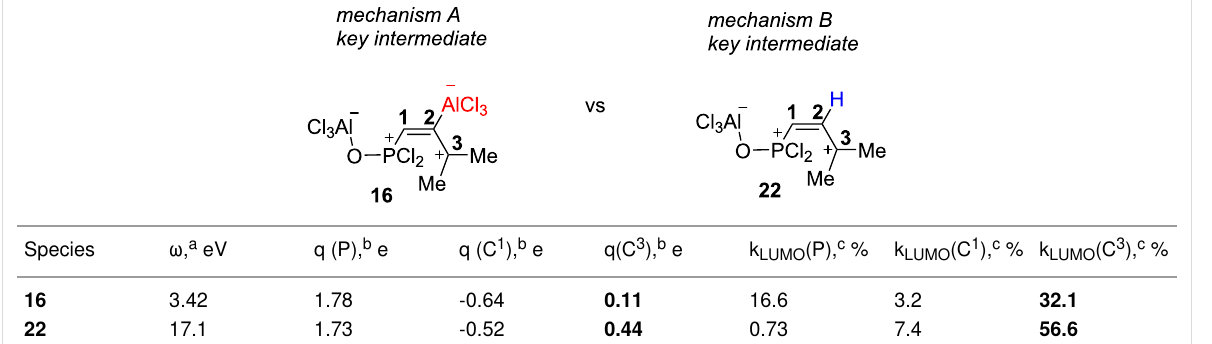
contribution into LUMO (56.6%) compared to that of 16 (0.11 e, 32.1%). Also, species 22 is five times more electrophil- ic than 16 according to values of ω . Visualizations of the LUMO for 16 and 22 are shown on Figure